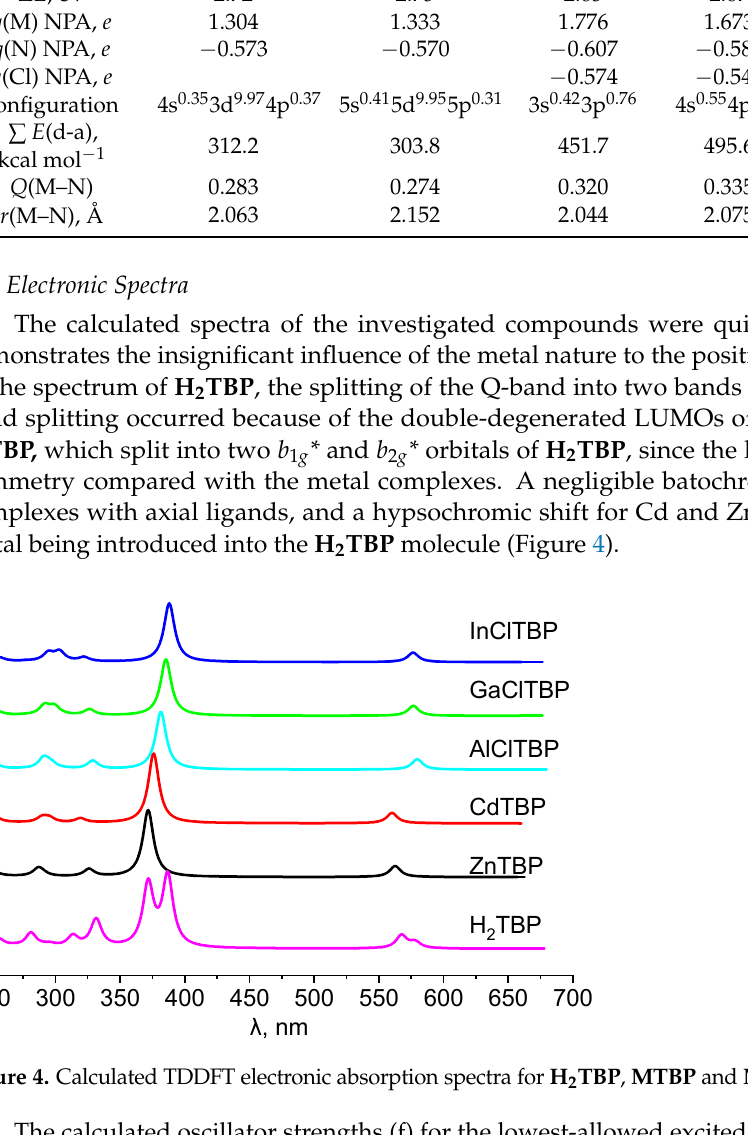
Table 3. Calculated composition of the lowest excited states and corresponding oscillator strengths for H 2 TBP and MTBP complexes. State